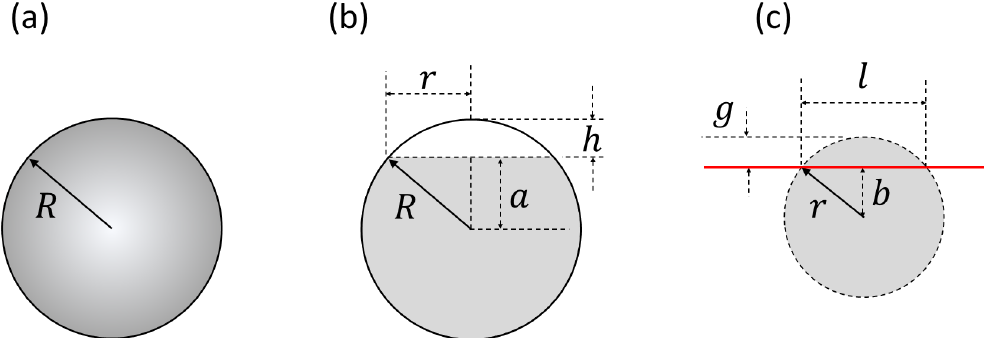
Figure 2. The key geometry defining ( a ) the sphere, ( b ) the cross-section of a spherical particle, ( c ) the line intercept taken through a circle cross-section of a